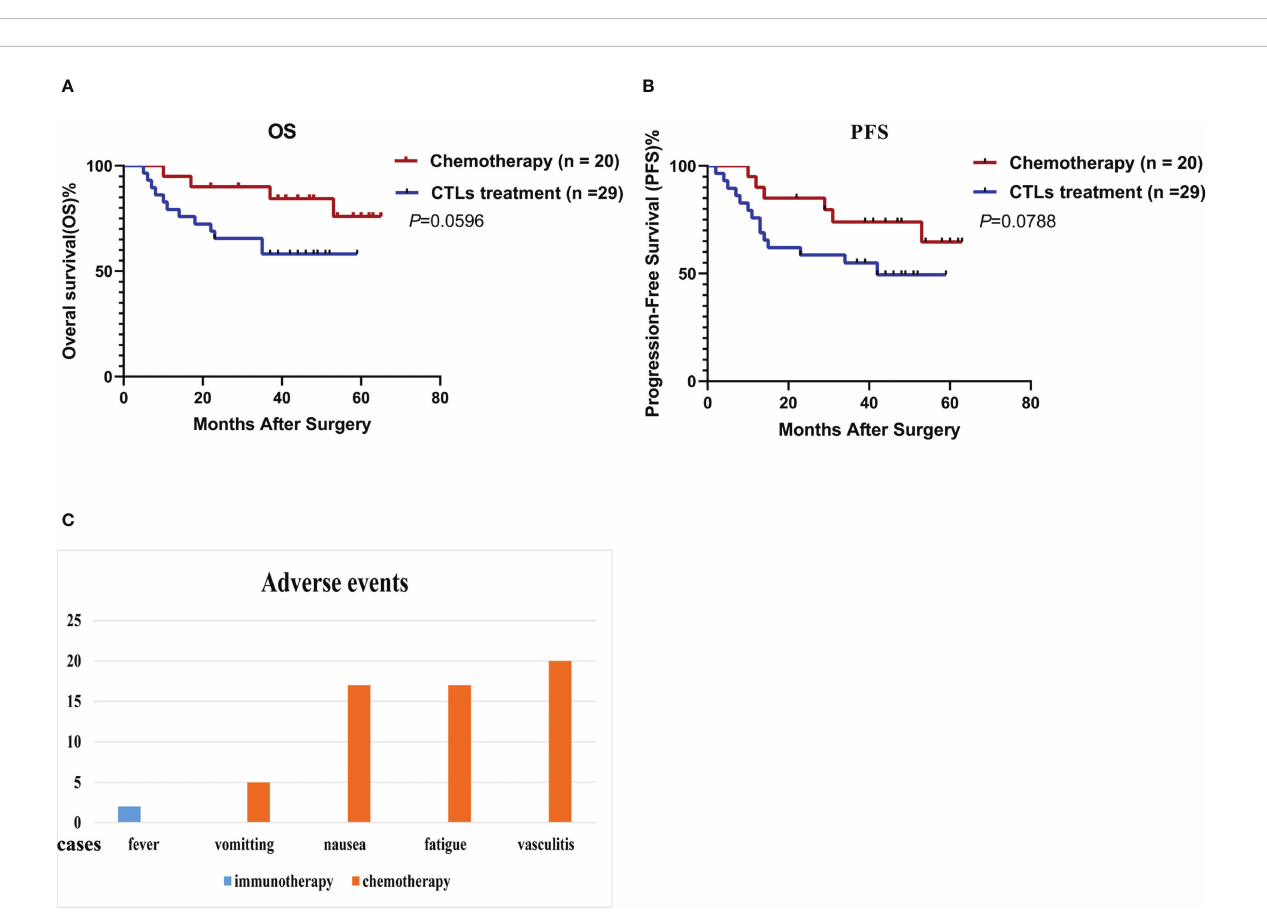
FIGURE 3 Cytotoxic T lymphocytes induced by rAAVs are effective and well-tolerated. (A) Overall survival (OS) and (B) progression-free survival (PFS) estimated by the Kaplan-Meier method. (C) Adverse events in both